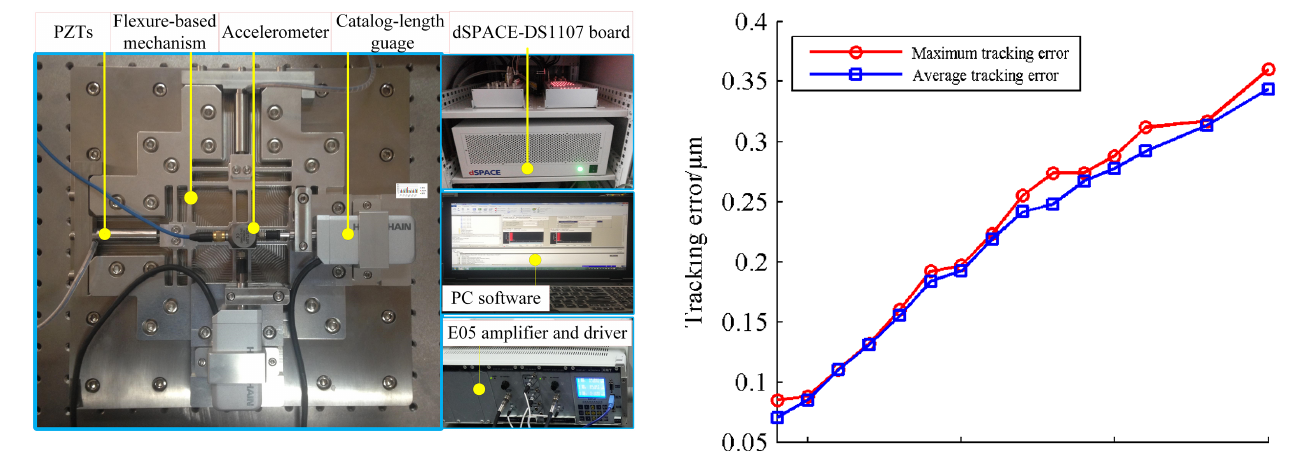
Figure 3. The experimental platform of the flexure-based compliant stage.